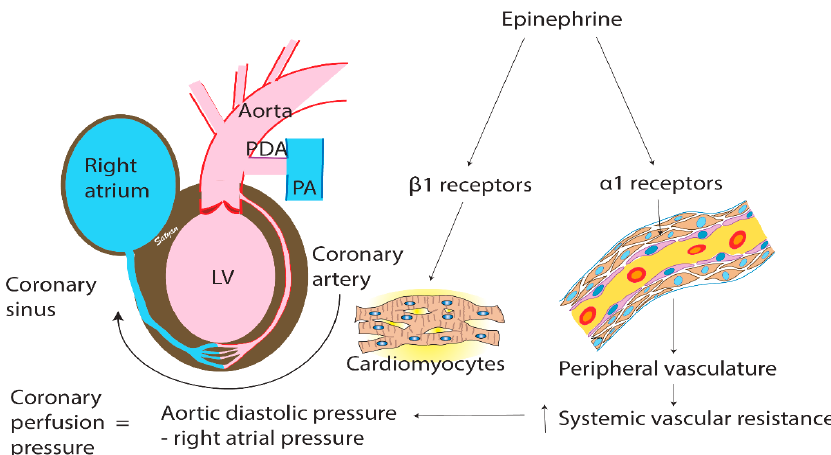
Figure 1. Coronary perfusion pressure (CPP) and the mechanism of action of epinephrine. CPP is calculated as the difference between the aortic diastolic pressure and the right atrial pressure serves as a surrogate to coronary blood flow. In the premature infant, the effect of a left to right (from aorta into pulmonary artery) flow on coronary blood flow is unknown. Epinephrine’s effect on alpha-adrenergic receptors on peripheral vasculature leads to vessel contraction and a rise in systemic vascular resistance that can increase CPP. Epinephrine also exerts stimulation of beta-adrenergic receptors on myocytes that increase cardiac contractility. α : Alpha; β : Beta; LV: Left ventricle; PA: Pulmonary artery; PDA: Patent ductus arteriosus. Copyright Satyan